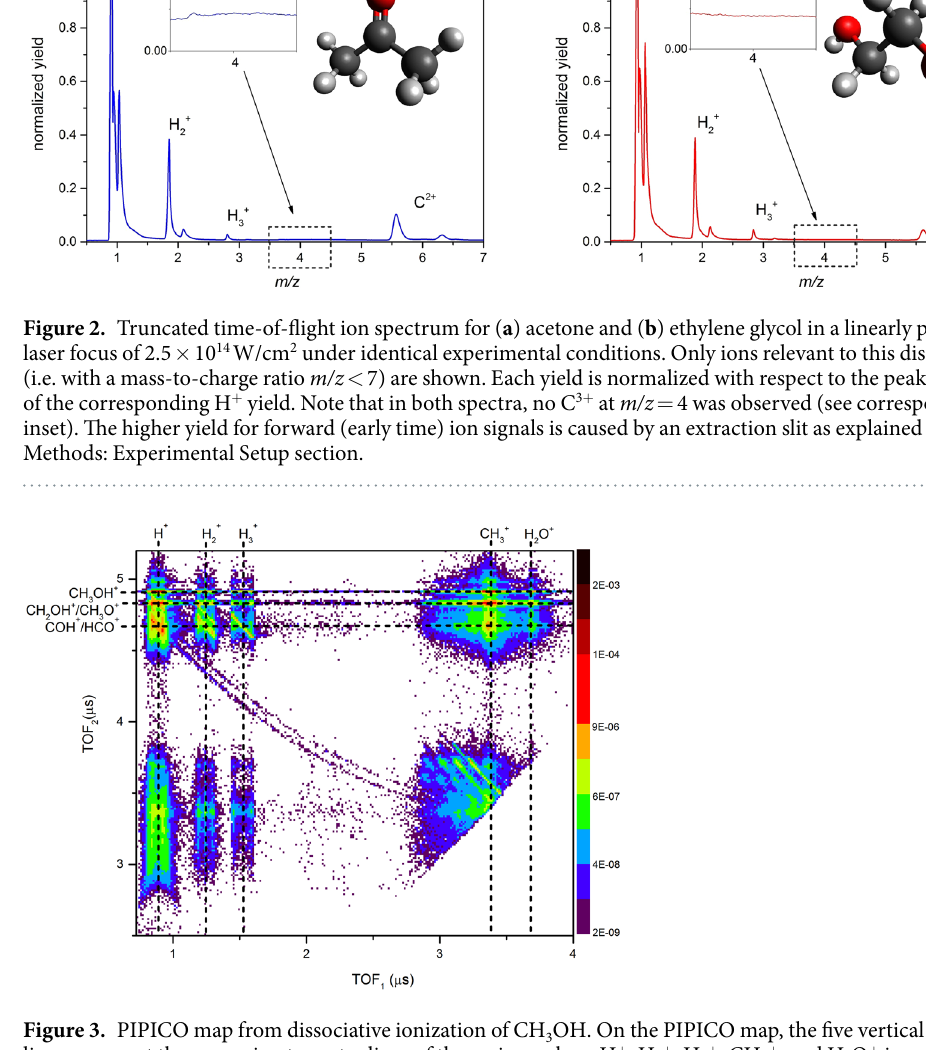
Figure 3. PIPICO map from dissociative ionization of CH 3 OH. On the PIPICO map, the five vertical (dashed) lines represent the approximate center lines of the regions where H + , H 2 + , H 3 + , CH 3 + , and H 2 O + ions are recorded. The three horizontal (dashed) lines indicate CH 3 OH + , CH 2 OH + /CH 3 O + , and COH + /HCO + ion regions. The contour region with an approximate slope of − 1 at the intersection of the vertical H 3 + line and the horizontal COH + /HCO + line represents the coincidence channel of H 3 + and COH + /HCO + . The logarithmic color scale depicts the event rate in units of